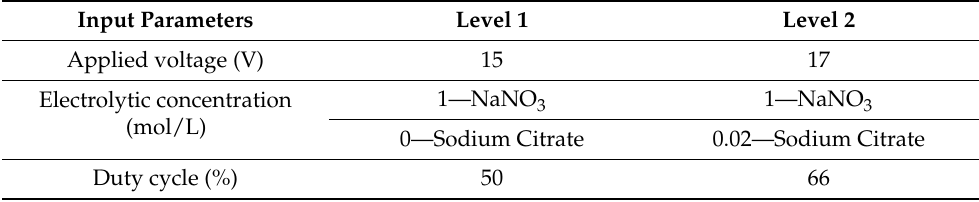
Table 2. Selection of Process parameters and its